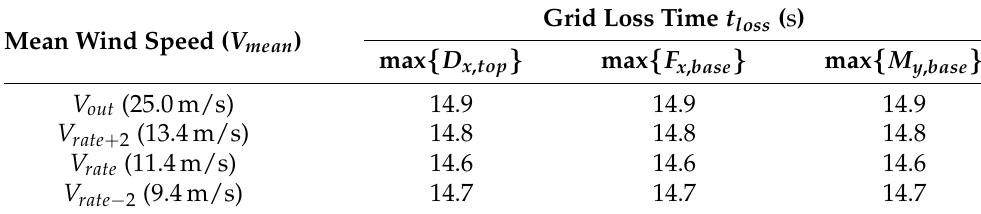
Table 2. Grid loss timing to achieve the worst loading on wind